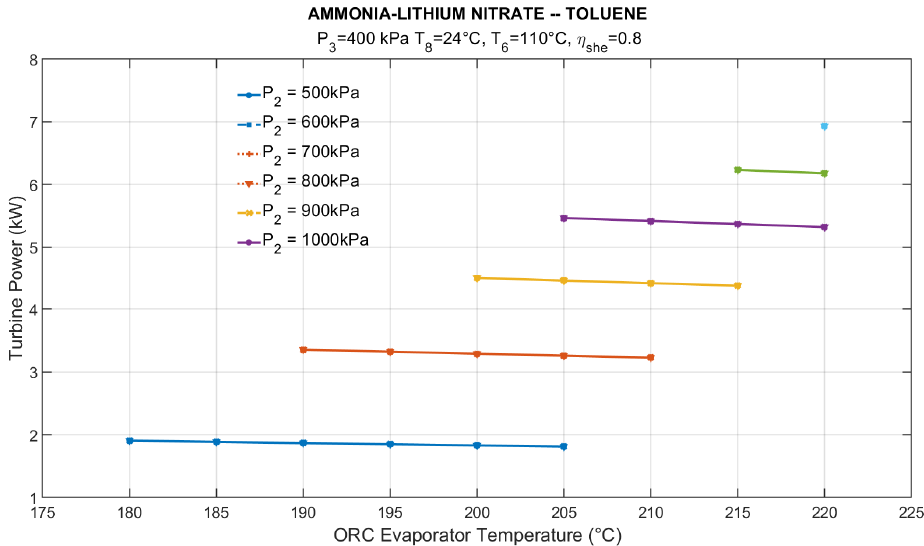
Figure 16. NH 3 -LiNO 3 –C 7 H 8 turbine power as a function of heat source temperature and cooling temperature at di ff erent operating conditions.